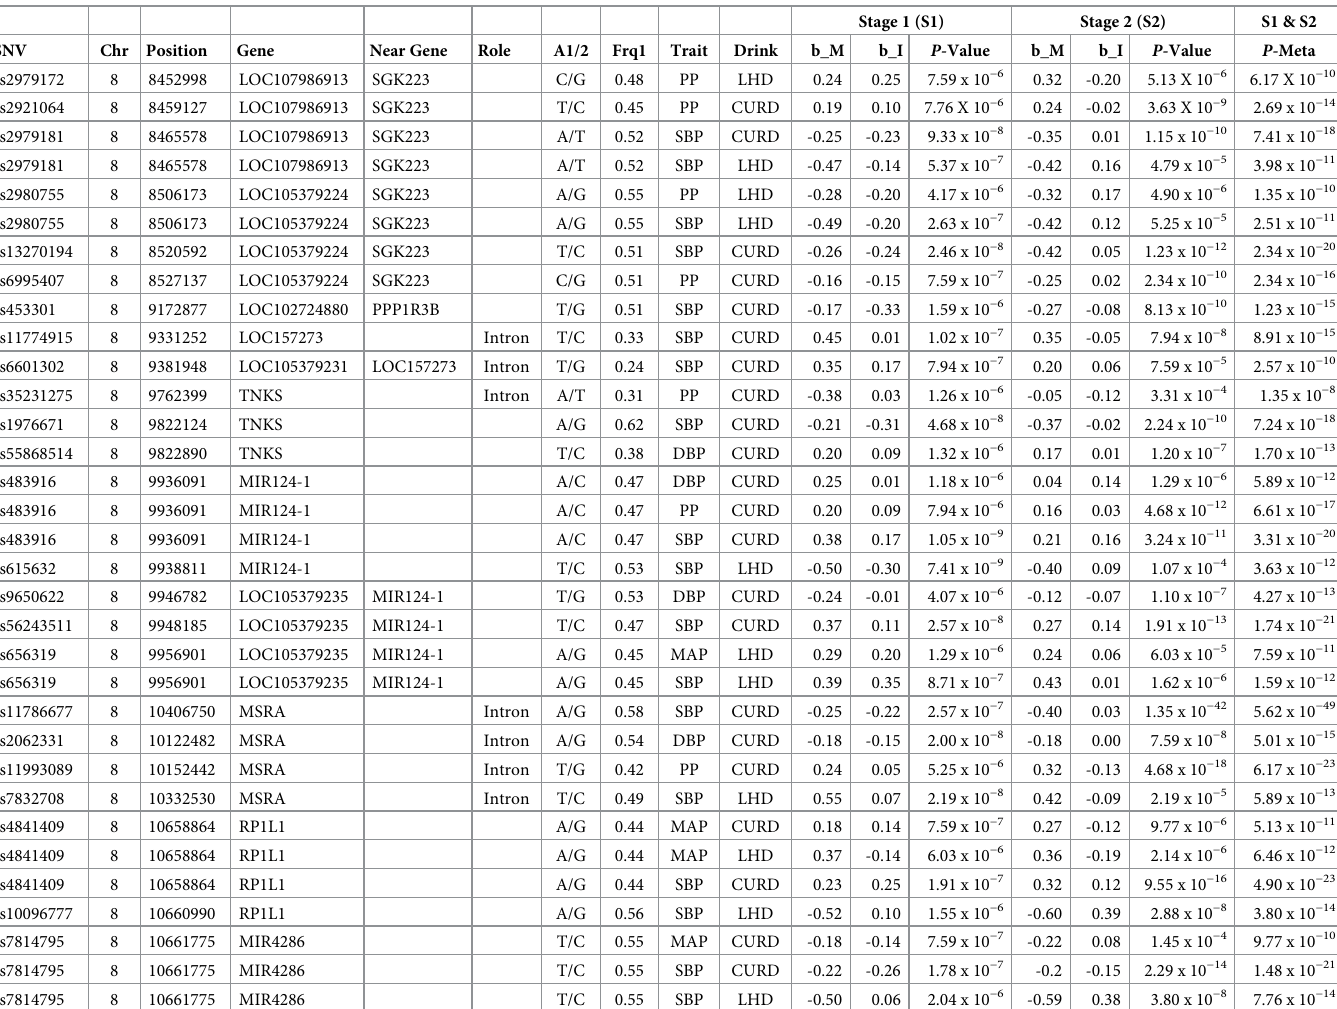
Table 1. Novel SNVs/Genes associated with BP traits in European